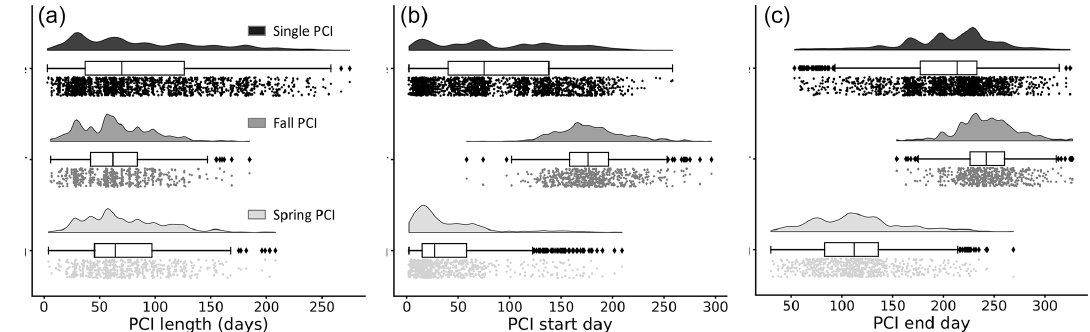
Figure 5. Frequency distributions of (a) duration, (b) start day (day of year), and (c) end day (day of year) of the PCIs, grouped by PCI type. Single PCIs have the longest range in length, while fall PCIs tend to be the shortest. Single PCIs have the largest range of start and end days, while the spring and fall PCIs tend to start and end within a smaller window. These rain-cloud plots show the same data visualized in three different ways for each group: frequency distribution, boxplot with quartiles (outliers represented as points), and a jitter plot of data